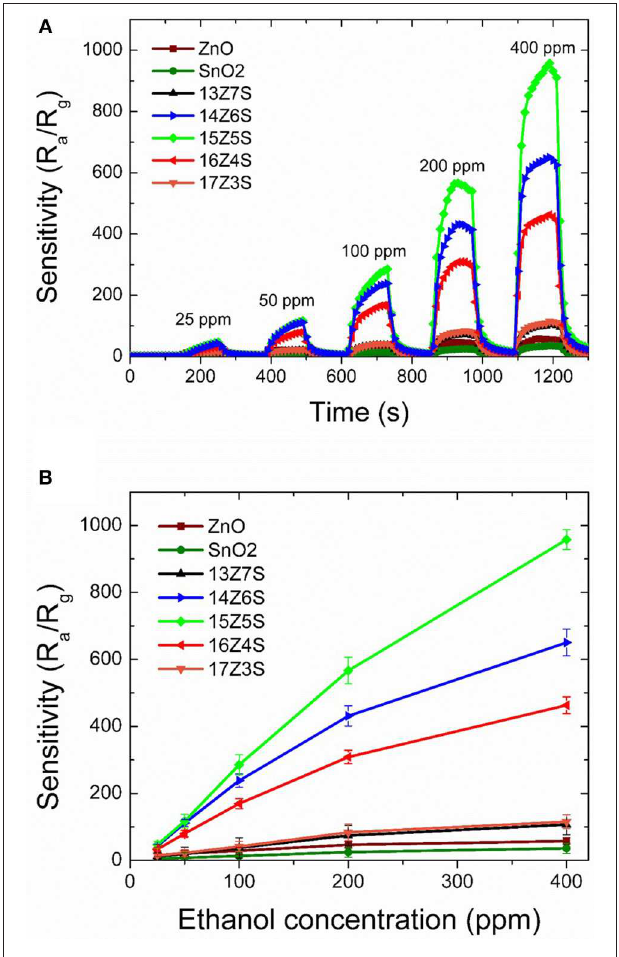
FIGURE 4 | (A) Time-dependent response recovery characteristics of various ZnO/SnO 2 nanostructure sensors with different gas concentrations at an optimum operating temperature of 400 ◦ C, (B) Sensitivity of various ZnO/SnO 2 nanostructure sensors as a function of ethanol concentrations.